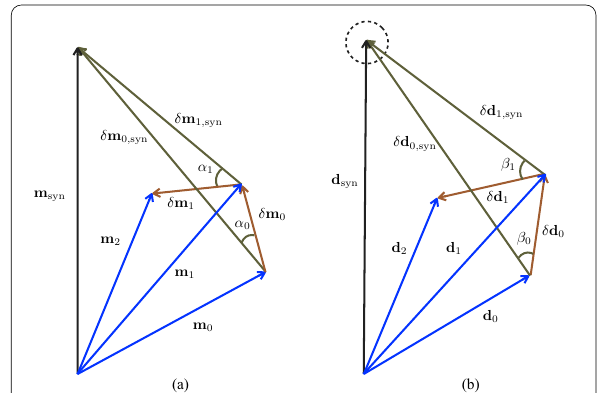
Fig. 13 Schematic 2D illustration showing the concepts of a model and b data vectors. The vectors m syn , m 0 , and m k ( k = 1,2, ...) represent the synthetic model, the initial model, and the model at the k th iteration, respectively. The vectors d syn and d k ( k = 0,1,2, ...) represent the synthetic data and the responses calculated from the model at the k th iteration, respectively. δ m k and δ d k are the model and data correction vectors, respectively. The MCVAs and DCVAs are indicated by α k and β k , respectively, for each iteration step. The dashed circle in ( b ) represents the assumed observation error